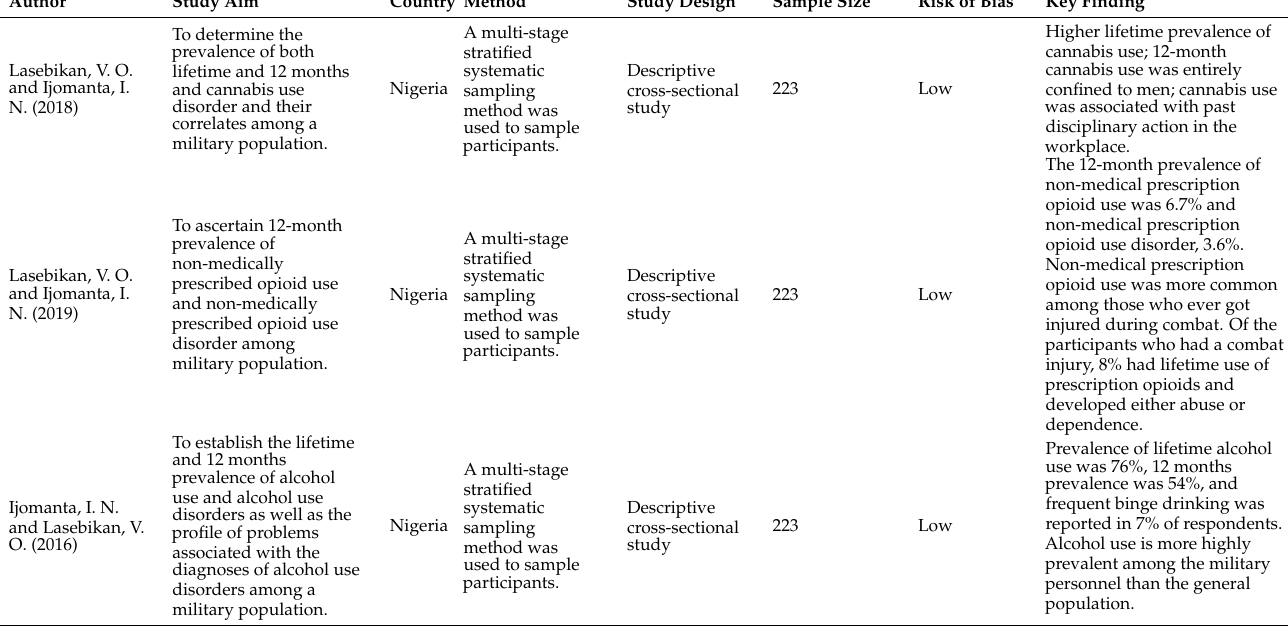
Table 1. Summary of included